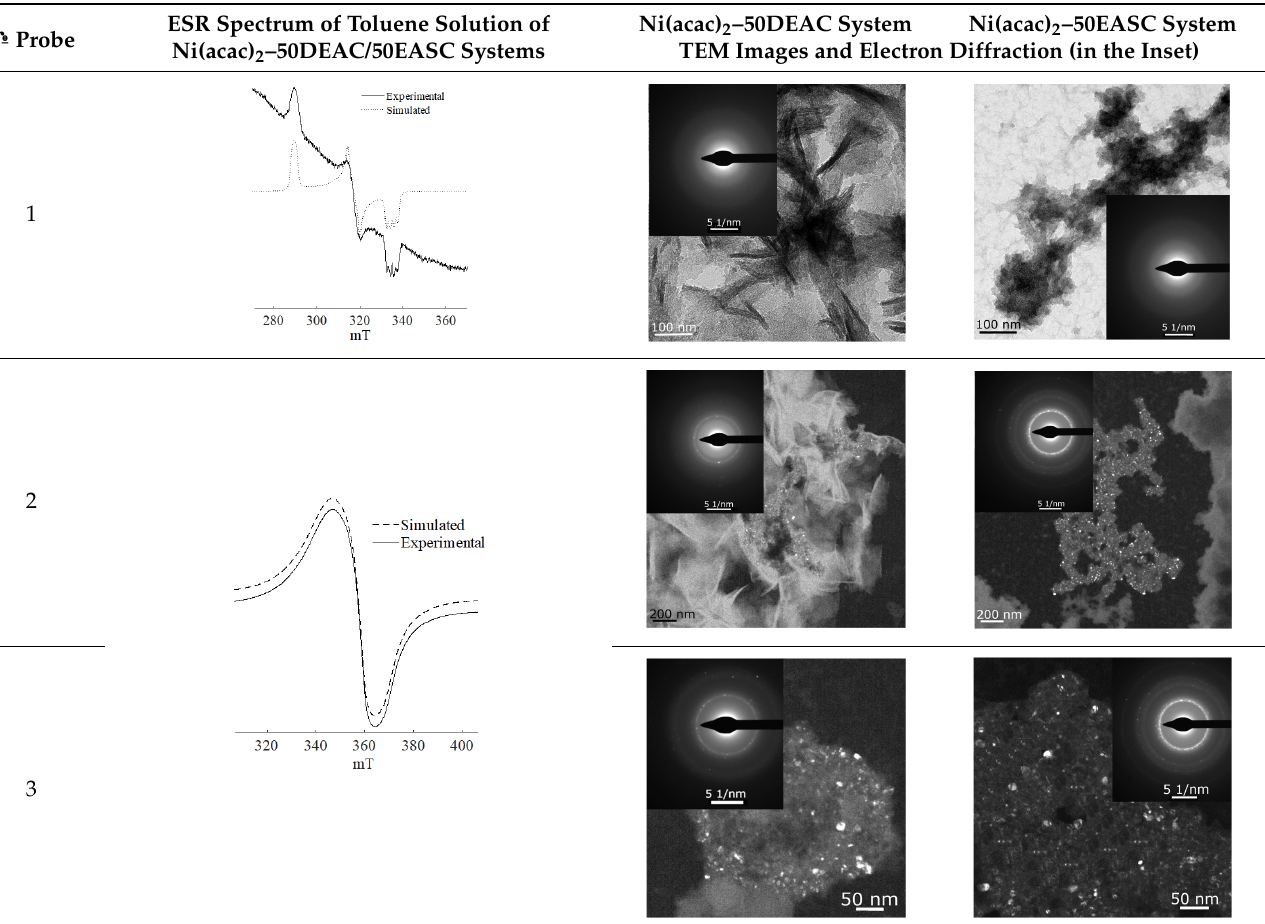
Table 2. TEM and ESR spectroscopic data for the Ni(acac) 2 –50DEAC or Ni(acac) 2 –50EASC systems, where probes (1) were selected over 1 min after components mixture, (2) t the moment of maximum ethylene absorption rate, (3) after a drop in the rate of ethylene absorption. Data were taken from ref. [13,17].